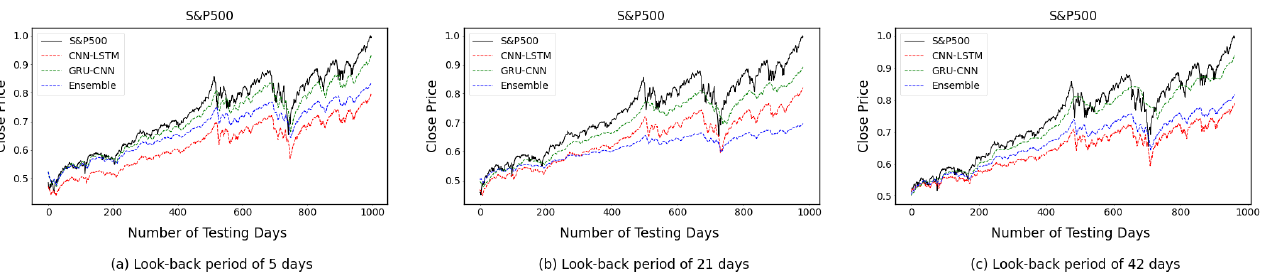
Figure 11. Comparison of true and predicted close prices of the S&P500 index between different look-back periods for five-time-step prediction over the period from 1 January 2000 through 31 December 2019.